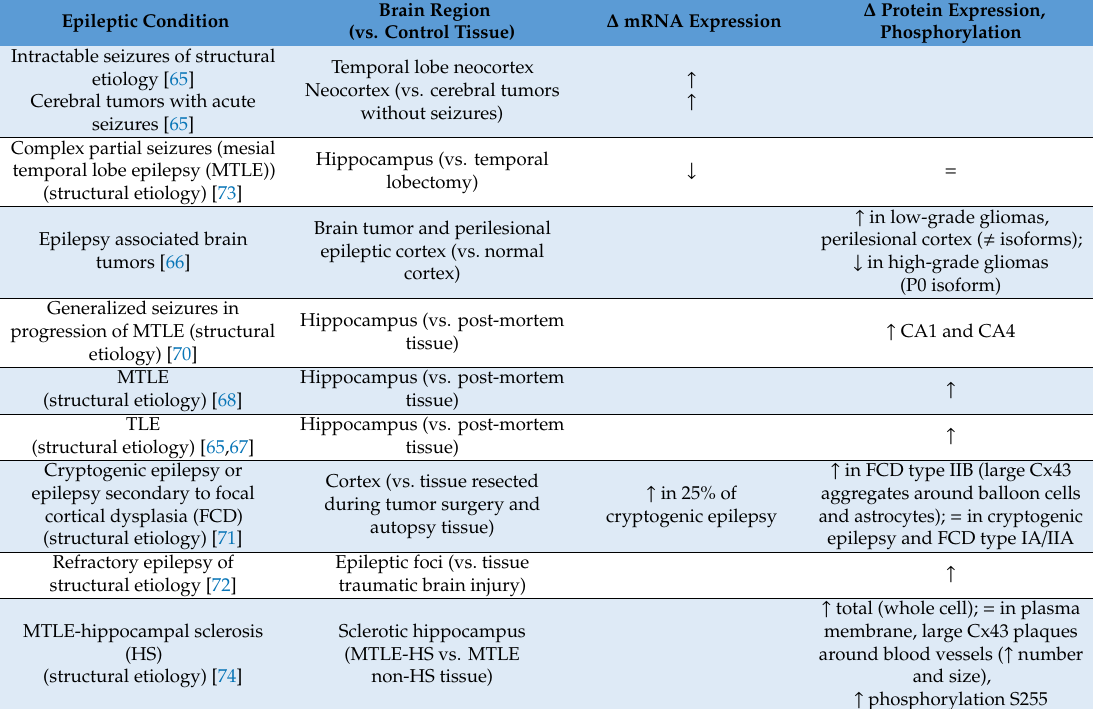
Table 1. Cx43 expression and phosphorylation changes associated with human